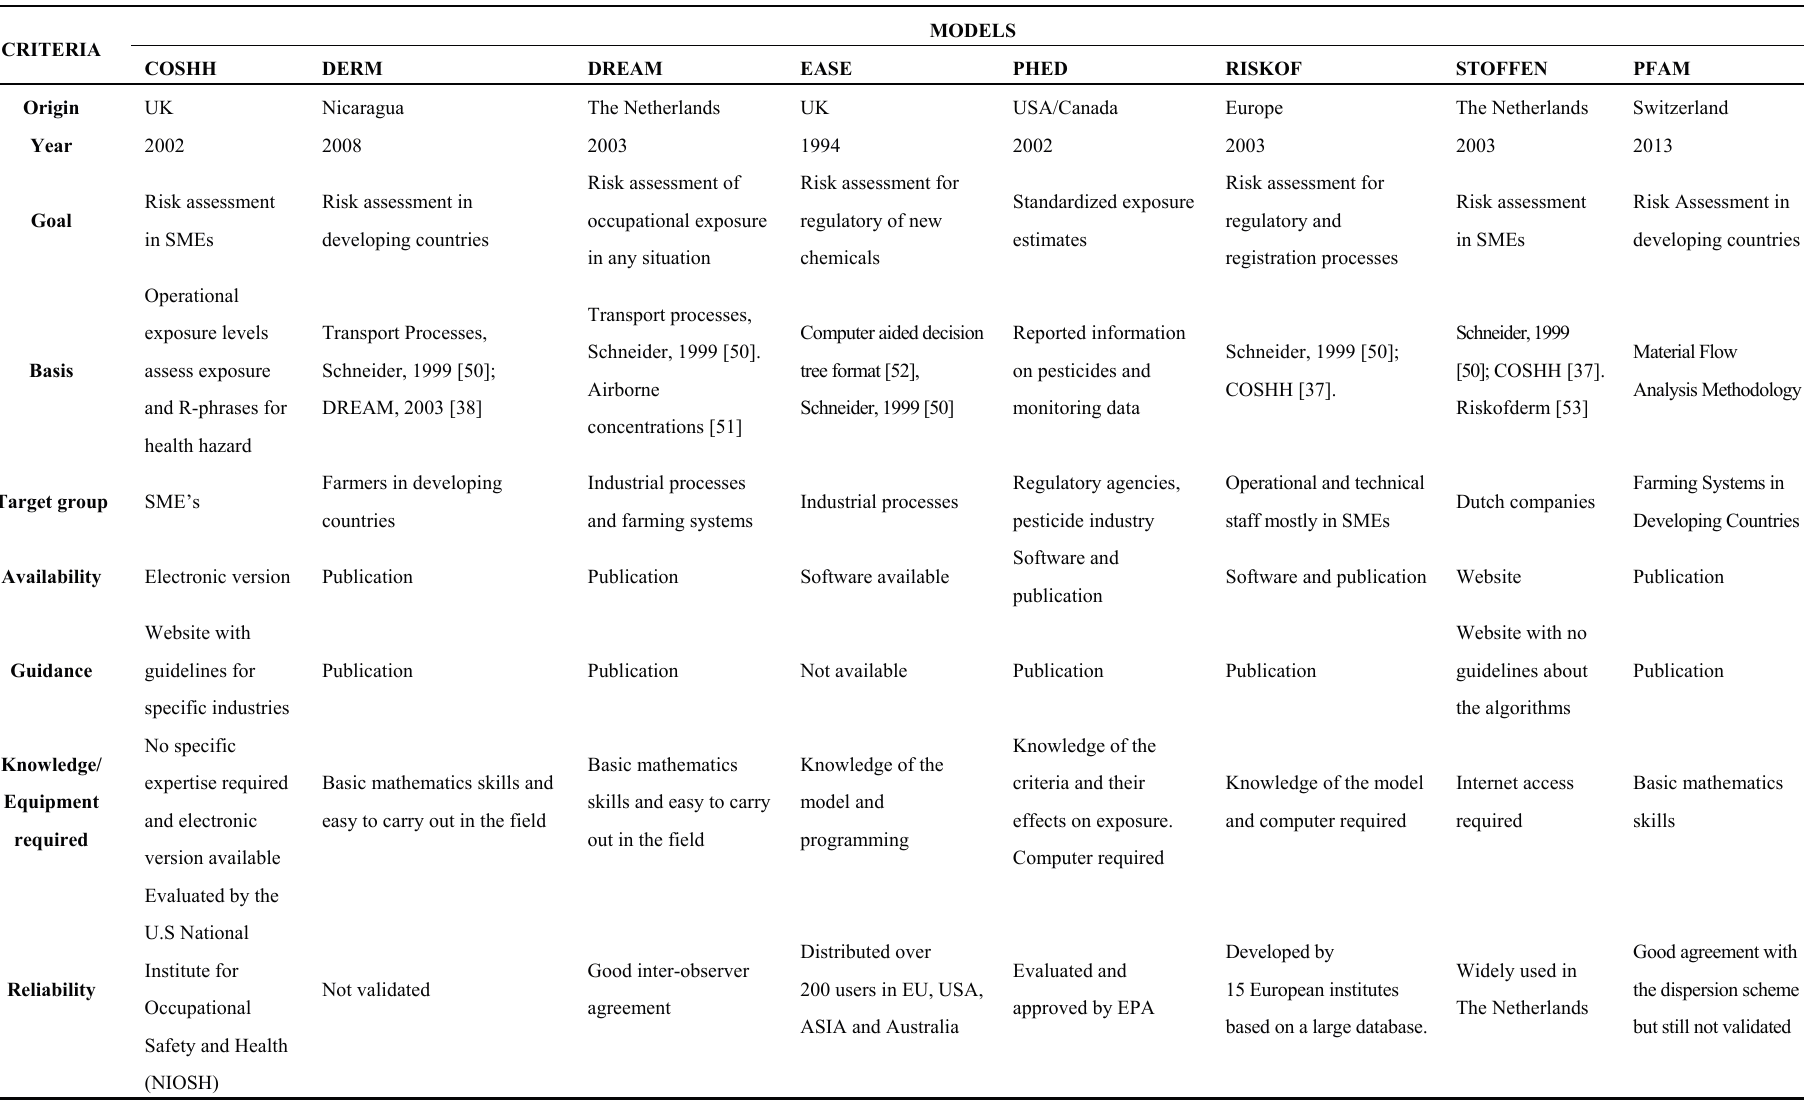
Table 3. Description of the evaluated models for dermal exposure assessment according to the multi-criteria